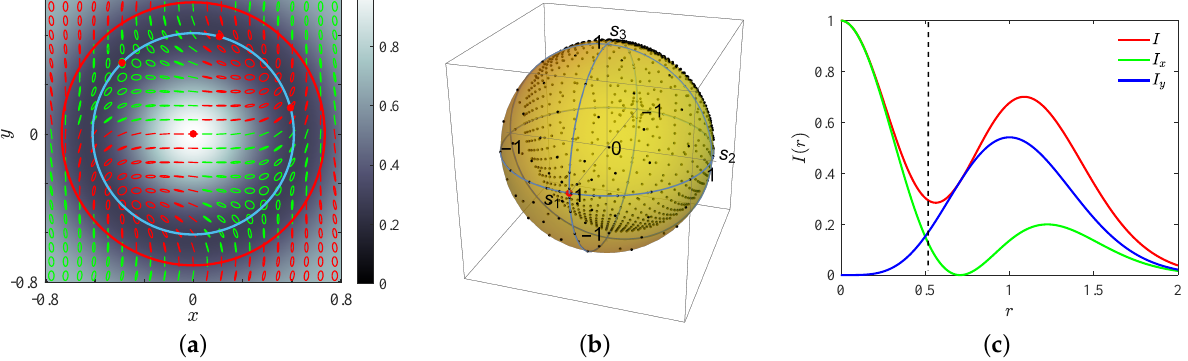
Figure 4. ( a ) Transverse intensity and polarization pattern for the beam in Equation (22); where handedness is codified by the color of the ellipses (green = right, red = left, and red is also used for linear polarization), and distances are normalized to the beam spot size; ( b ) corresponding states of polarization represented by black dots on the Poincaré sphere, and the red dot indicates horizontal linearly polarized light; ( c ) intensity profile and contribution of each field component where the black dots represent distances, r , where the optimum polarization for polarimetric measurements can be